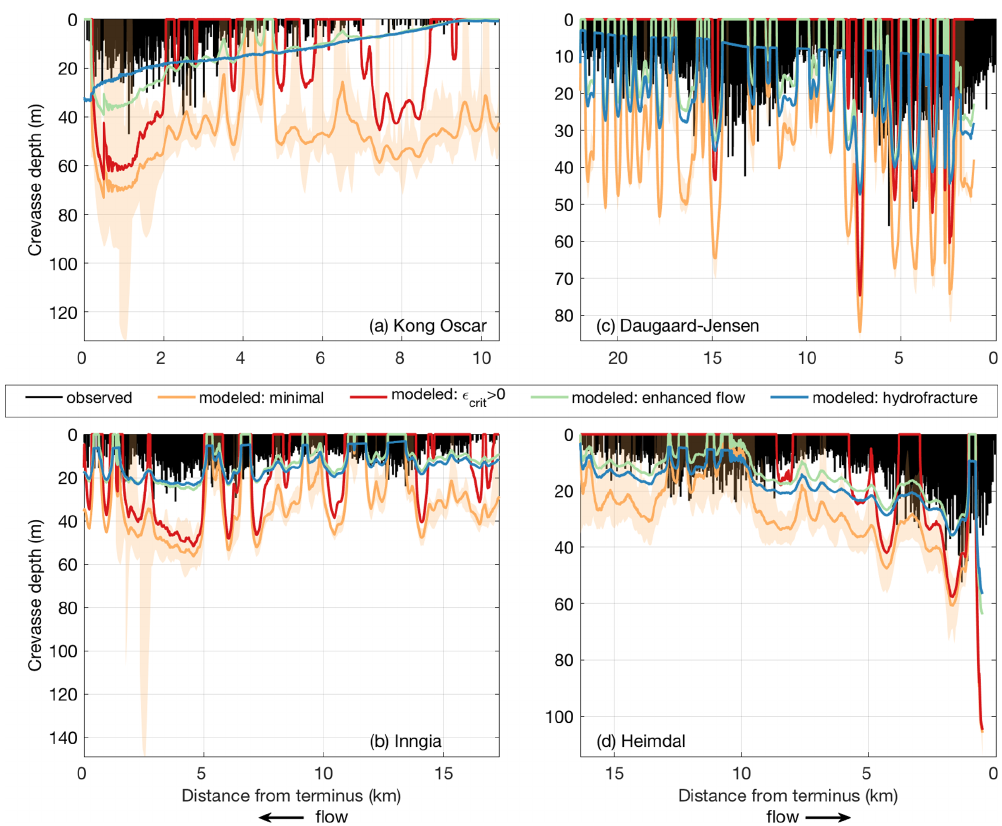
Figure 5. Profiles of all observed crevasse depths (black lines) and modeled crevasse depths (colored lines) computed from the median velocity profile for (a) Kong Oscar Glacier, (b) Inngia Isbræ, (c) Daugaard–Jensen Glacier, and (d) Heimdal Glacier. Orange colors show the median (line) and temporal range (shading) in modeled crevasse depths using the minimal Nye formation (i.e., no critical strain rate, uniform viscosity, no water). The red, green, and blue lines show the Nye-modeled crevasse depths with observation-based critical strain rates, flow enhancement, and flow enhancement with impounded water, respectively. The purple lines show the LEFM-modeled crevasse depths with the geometry-dependent stress intensity scaling factor calculated from